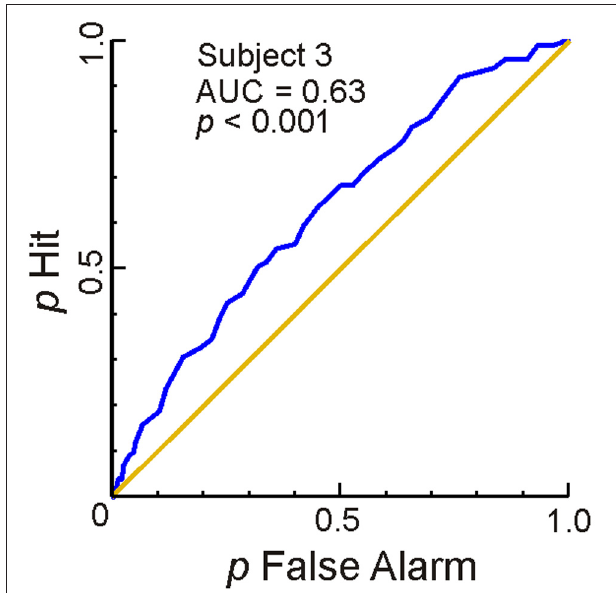
FIGURE 4 | Responses in left FG estimate the subject’s response on a trial-by-trial basis. ROC analyses of trial-by-trial responses were carried out using the BOLD responses to individual trials estimated using FIR modeling in Method 2 (see “Materials and Methods” for details). This figure shows the ROC curve ( blue ), the area under the ROC curve (AUC) and the p -value of AUC for one subject. The diagonal represents chance level performance (AUC = 0.5). The data from the remaining subjects are reported in the text. The average time course of the responses in FG across all sessions and subjects are shown in Figure A2 .